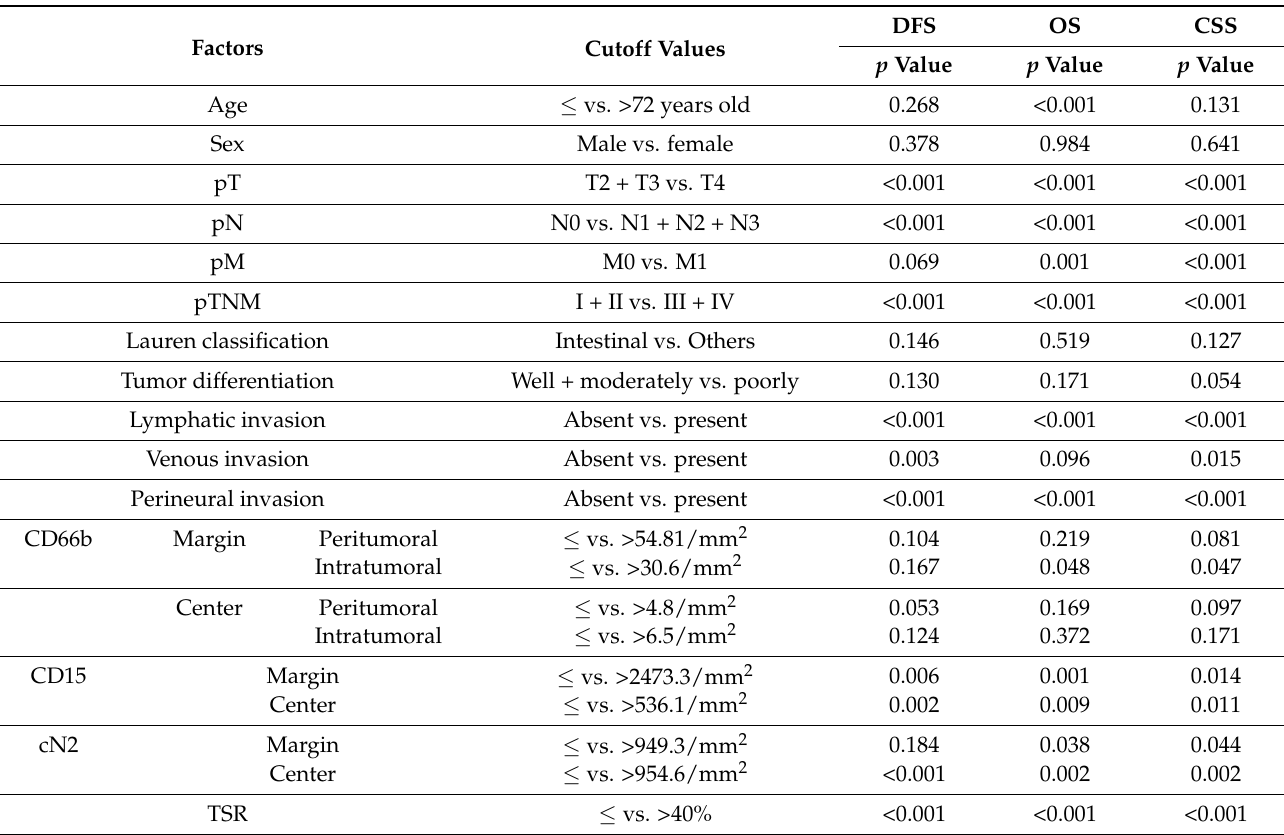
Table 1. The prognostic effects of the clinicopathological factors, tumor–associated neutrophils, and tumor—stroma ratio using the Kaplan—Meier curve analysis.